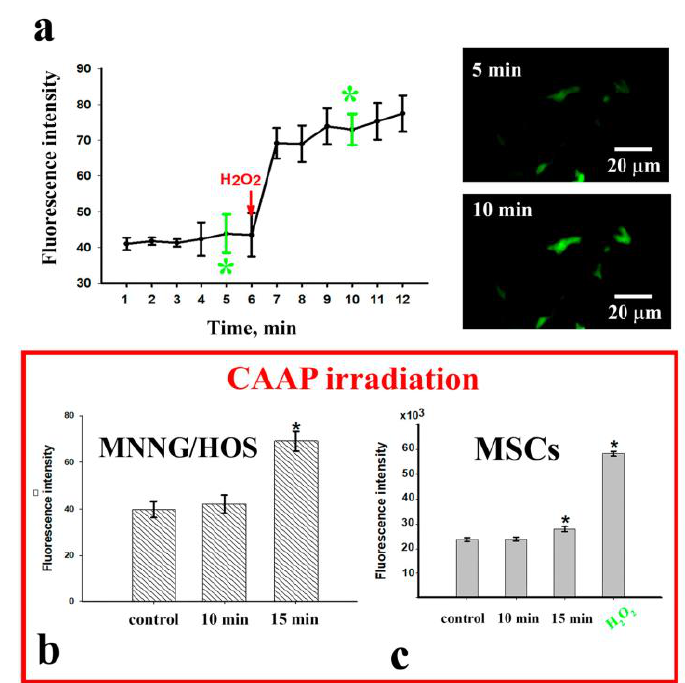
Figure 5. ROS formation in transfected MNNG/HOS cells detected by the level of HyPer sensor protein fluorescence in the cytoplasm and the level of the H 2 DCFDA dye fluorescence in MSCs: ( a ) the dynamics of the changes in the cell fluorescence before and after the addition of 100 µM of hydrogen peroxide (positive control); ( b ) change in the fluorescence of MNNG/HOS cells after CAAP irradiation; ( c ) change in the fluorescence of MSCs after CAAP irradiation. * p < 0.001 .